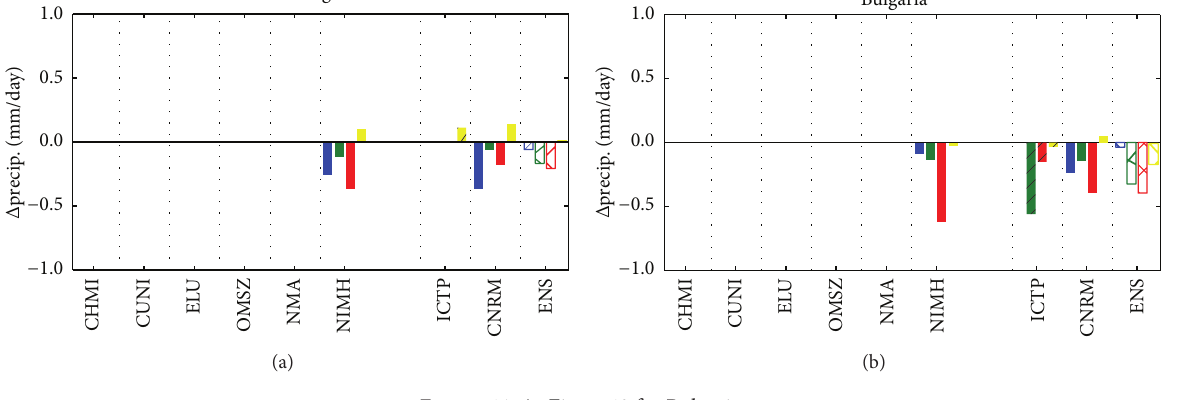
Figure 14: As Figure 10 for Bulgaria.